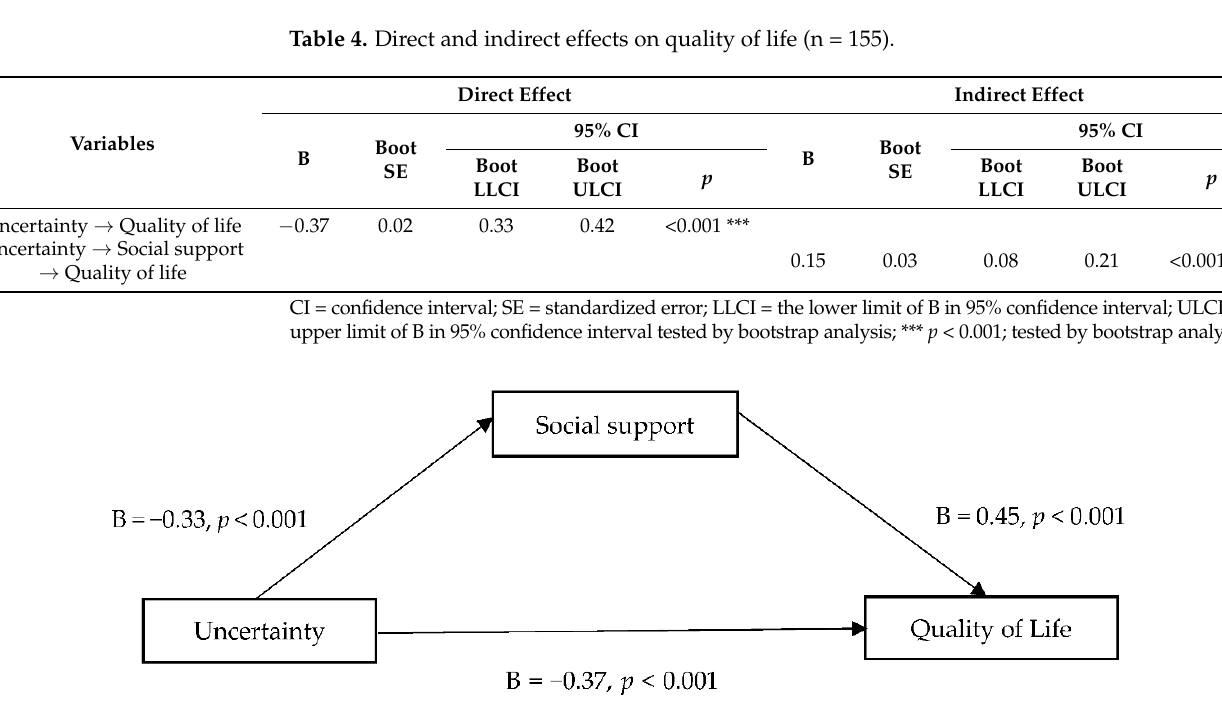
Figure 2. Mediating effects of social support on the relationship between uncertainty and quality of